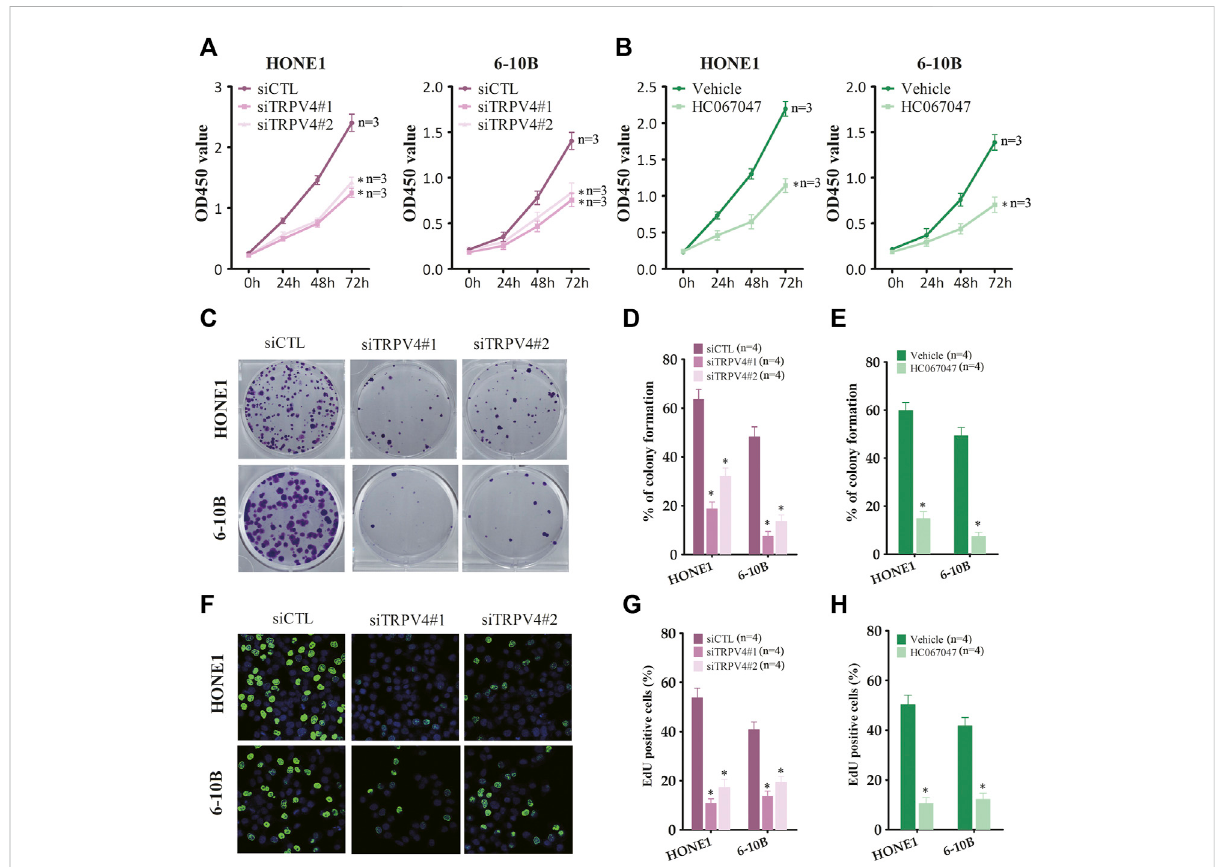
FIGURE 3 TRPV4 regulates NPC cells growth in vitro (A) Survival rates of HONE1 and 6 – 10B cells transfected with control siRNA (siCTL) or TRPV4 siRNA (siTRPV4#1 and siTRPV4#2) (n = 3). (B) Survival rates of HONE1 and 6 – 10B cells pre-treated with vehicle (0.1% DMSO) or HC067047 (4 μ M) (n = 3). (C,D) Representative images and number of colonies formed by NPC cells transfected with siCTL, siTRPV4#1 or siTRPV4#2 (n = 4). (E) Number of colonies formed by NPC cells pre-treated with vehicle (0.1% DMSO) or HC067047 (4 μ M) (n = 4). (F,G) Representative images and number of Edu-positive proliferative NPC cells transfected with siCTL, siTRPV4#1 or siTRPV4#2 (n = 4). (H) Edu- positive NPC cells pre-treated with vehicle (0.1% DMSO) or HC067047 (4 μ M) (n = 4). The data represent the mean ± SEM. * p < 0.05, versus vehicle or